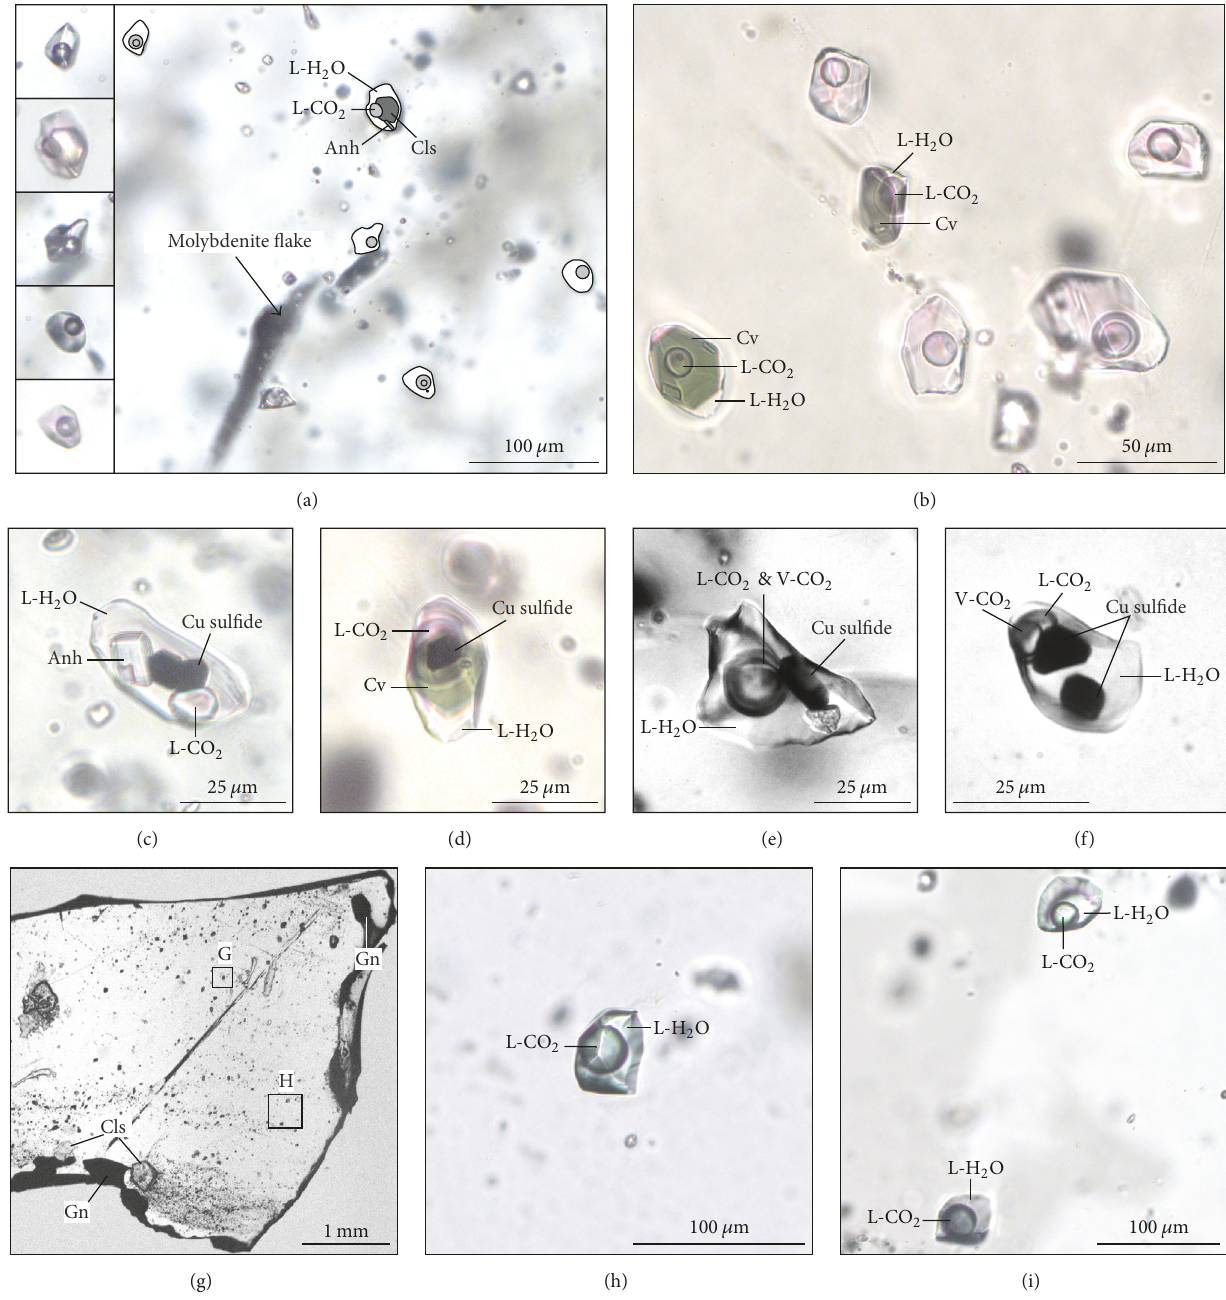
Figure 3: Photomicrographs of representative H 2 O-CO 2 fluid inclusions used for UV-fs-LA-ICP-MS analysis. (a) Fluid inclusion assemblage adjacent to a molybdenite flake in stage I quartz. Photomicrographs of the outlined fluid inclusions are shown in the left. Sample LS-540- 3. (b) Fluid inclusion assemblage with coexisting solid-bearing (covellite) and solid-free fluid inclusions in stage I quartz. Note covellite is translucent in transmitted light because it occurs as very thin flakes. This was created through focus stacking which combines 3 images taken at different focus distances in order to show all the fluid inclusions in focus. Sample LS-540-3. (c)–(f) Solid-bearing fluid inclusions in stage I quartz. Sample DH-505-8 and LS-540-3. (g) Distribution of fluid inclusions in a fragment of stage III quartz crystal. Areas indicated by letters are detailed in (h) and (i). Sample 470-F7-13. (h)-(i) Fluid inclusions in stage III quartz. Anh = anhydrite, Cv = covellite, Gn = galena, and Cls =